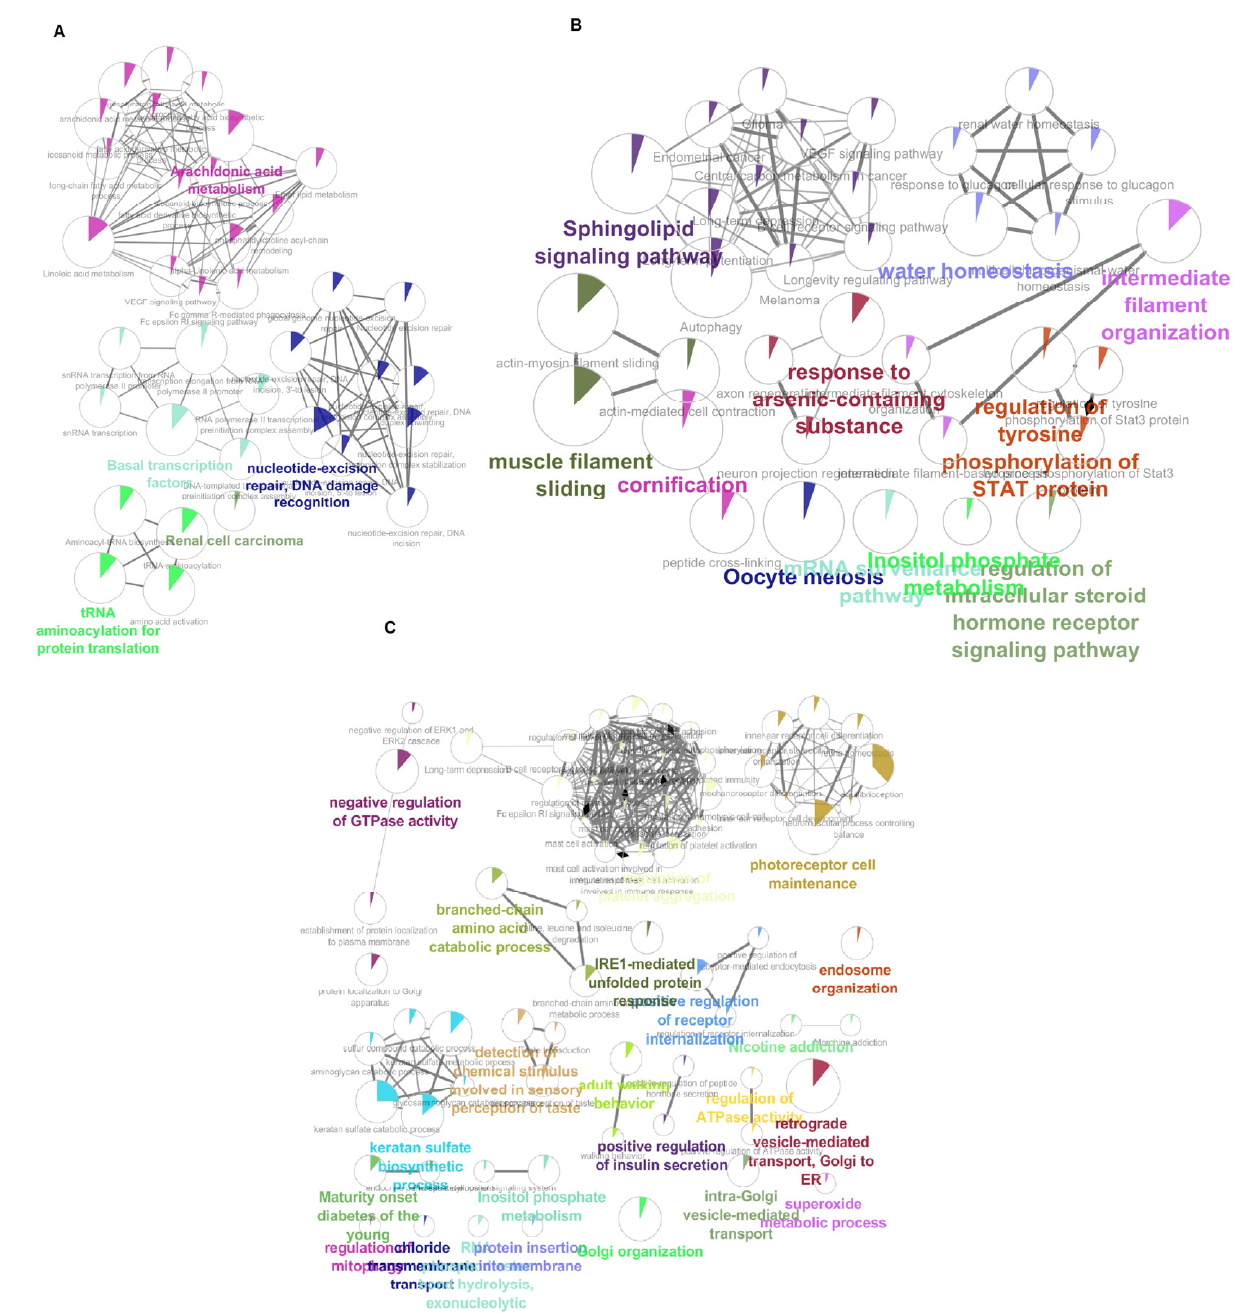
Figure 6. Gene ontology was constructed by integrating WikiPathways, Reactome, and KEGG. Each node shows a pathway or term and the percentage of visible shared genes between pathways or terms and edges present relationships between pathways: ( A ) relationship between enriched pathways and genes in CM (core module); ( B ) relationship between enriched pathways and genes in CN (core nodes); ( C ) relationship between enriched pathways and genes in DN (driver nodes).